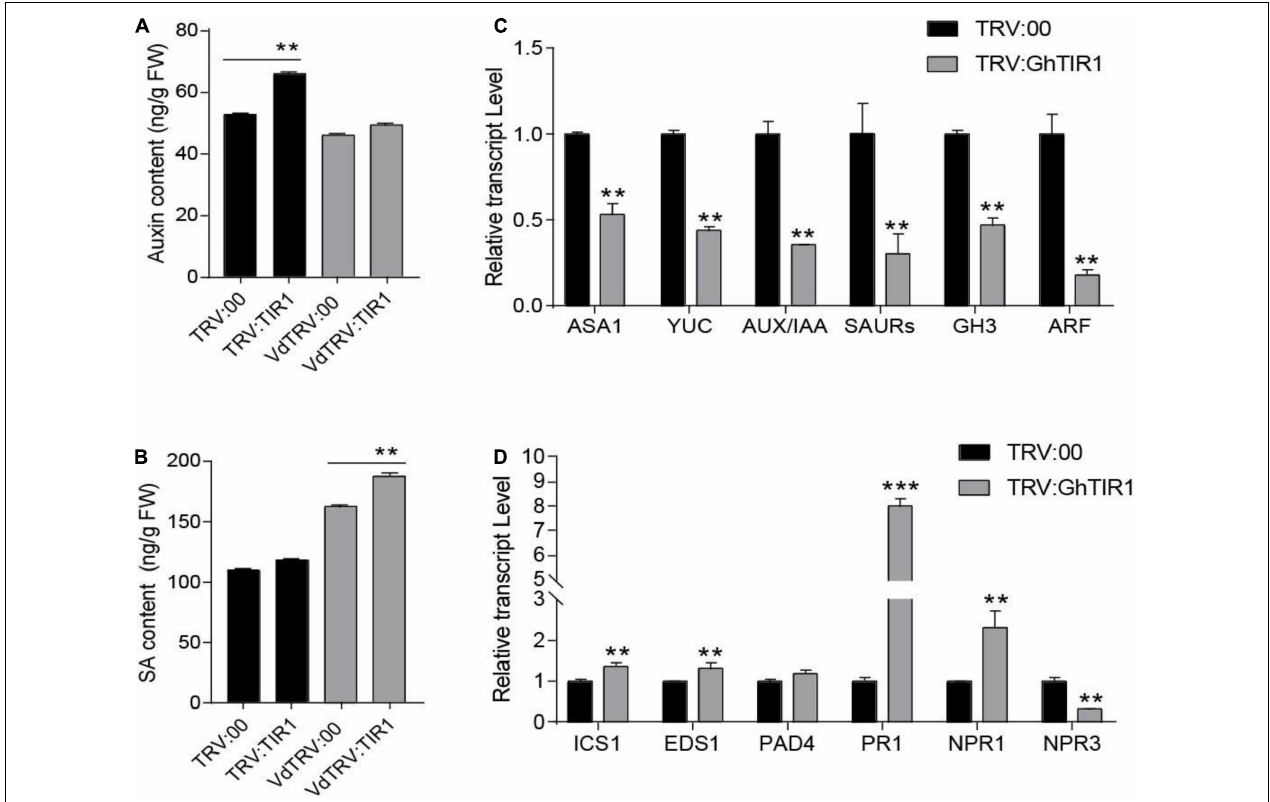
FIGURE 5 | GhTIR1 knockdown affects contents of IAA and salicylic acid (SA) and expression of their related genes. (A) The amount of auxin in leaves of GhTIR1 -silenced plants compared with the control at 6 h after Verticillium dahliae infection. (B) SA content in leaves of silenced plants compared with the control at 6 h after V. dahliae infection. The error bars indicate the SD of three biological replicates in panels (A,B) . Statistical significance was determined by Student’s t -test: ** P < 0.01. (C) The expressions of auxin-related genes in TRV:GhTIR1 plant roots compared with the control at 6 h after V. dahliae infection. (D) The expressions of SA-related genes in TRV:GhTIR1 plant roots compared with the control at 6 h after V. dahliae infection. Statistical significance as compared with TRV:00 in panels (C,D) , was determined by Student’s t -test: ** P < 0.01, *** P <